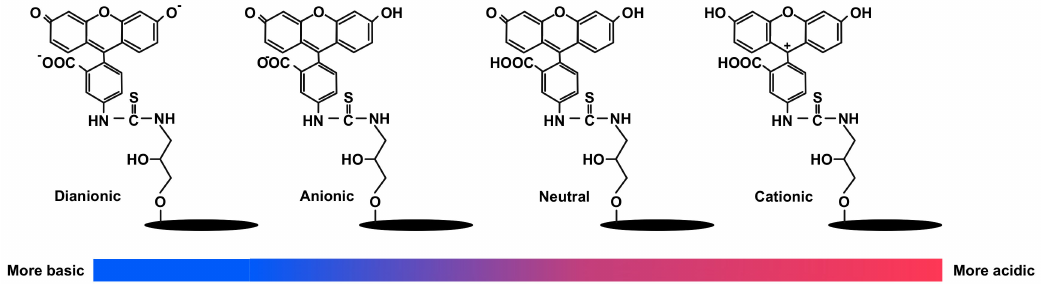
Figure 4. Di ff erent isoforms of FITC-CNC that present predominantly at di ff erent pH